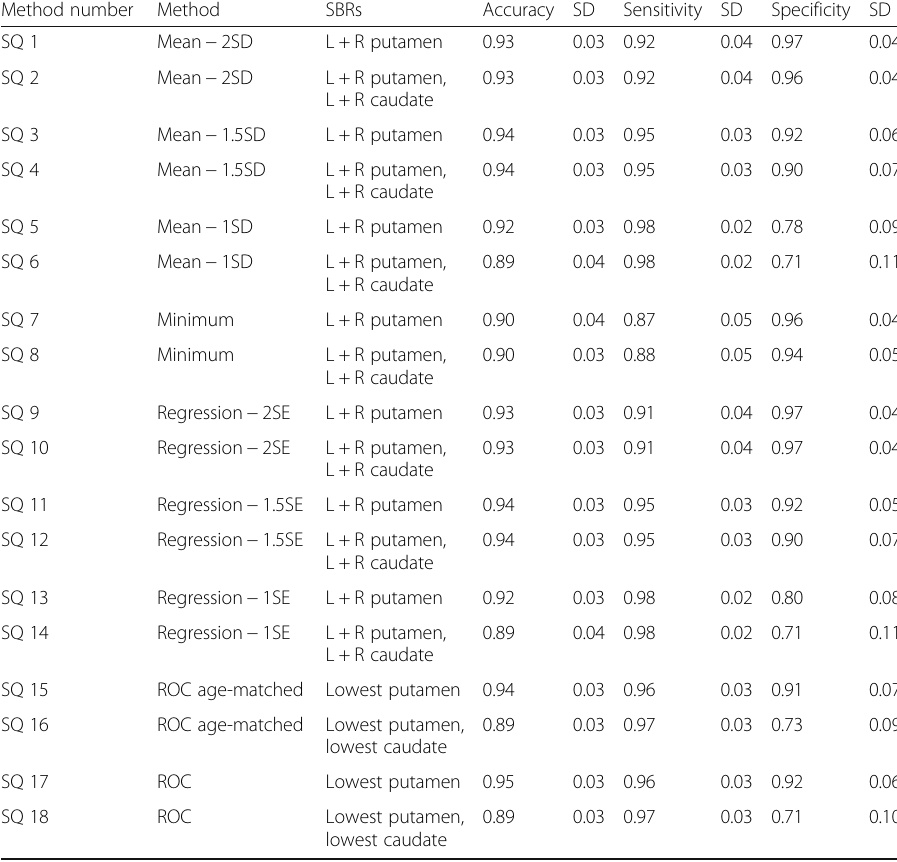
Table 5 Semi-quantitative results for PPMI database